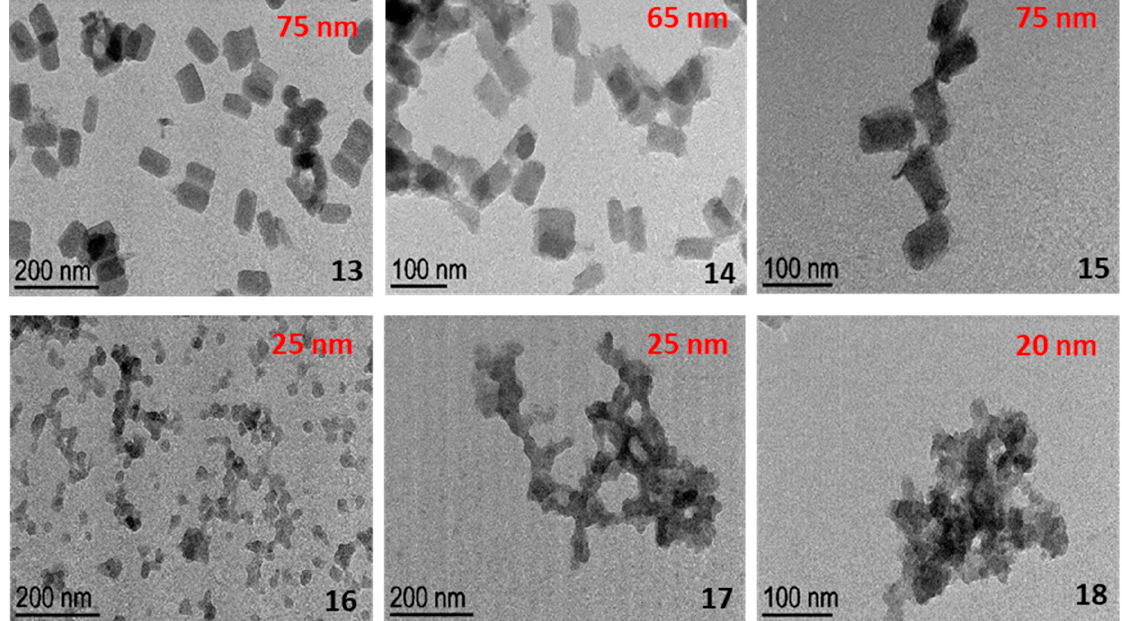
Figure 4. TEM images of the [Fe(Htrz) 2 (trz)](BF 4 )@SiO 2 nanoparticles obtained following synthetic route D with ω = 10 (upper banner) and ω = 5 (bottom banner) with increasing quantity of ammonia (0, 0.062 and 0.124 mL) from the left to the right (1 eq of TEOS is used for all experiments carried out at 293 K).